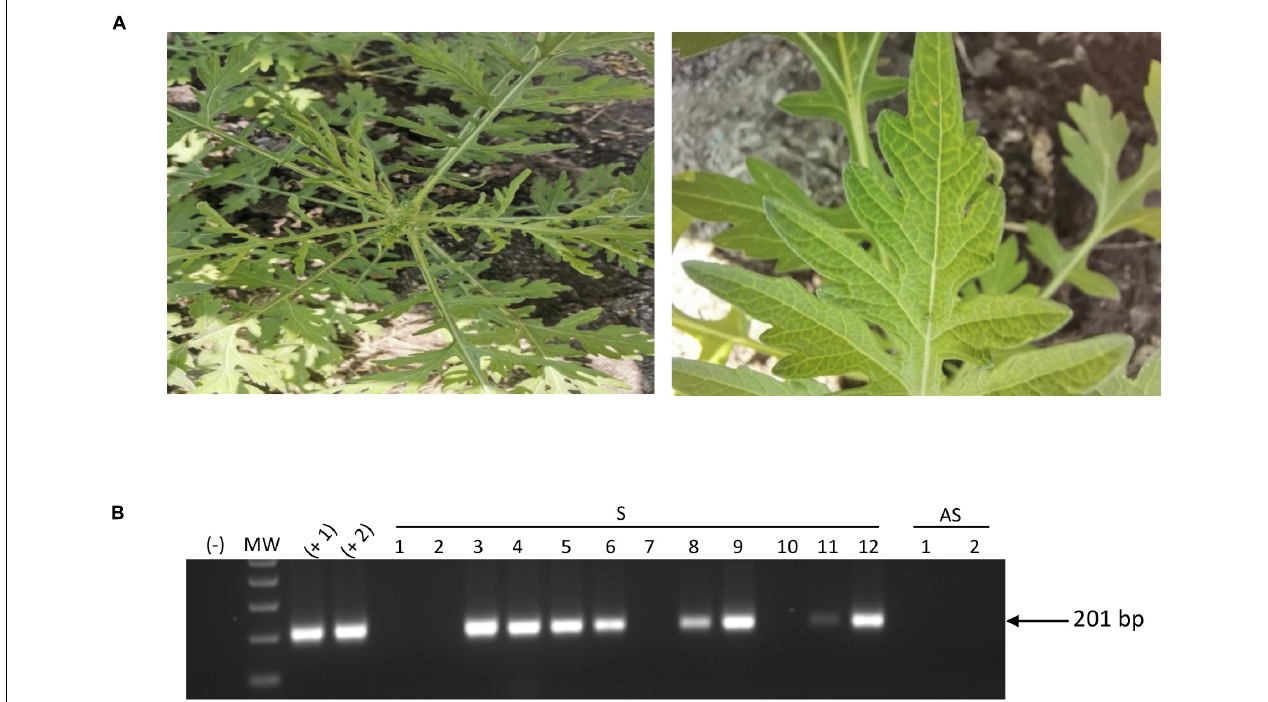
FIGURE 2 | Incidence of Galium leaf distortion virus (GLDV) in Tecomán, Colima region. (A) Samples of Galium mexicanum showing leaf distortion and foliar chlorosis symptoms were collected in the interface area surrounding cultivated area in Tecomán, Colima region in 2021. (B) Total DNA (100 ng) of 12 symptomatic Galium mexicanum samples were used for PCR-based molecular detection of GLDV using viral specific primers. (–), negative non template control, MW, molecular weight marker, ( + 1), and ( + 2) plasmidic GLDV-1, and GLDV-2 isolates positive controls, respectively, S, symptomatic plants, AS, asymptomatic plants. The size of expected amplicon is